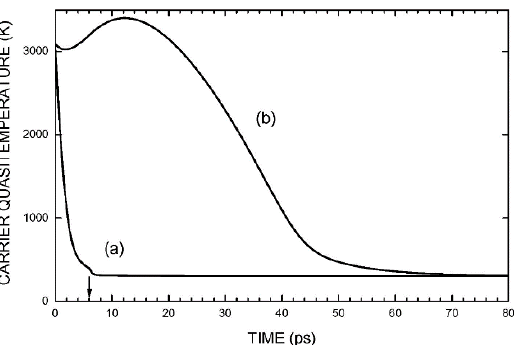
Figure 8. Comparison of the evolution of the carriers’ temperature when (a) is taken a unique quasitemperature for the phonons modes, and (b) the one when it is calculated the evolution of the quasitemperature of each phonon mode. As shown in Figure 10 the latter agrees quite well with the experimental data. (Algarte 70 ).